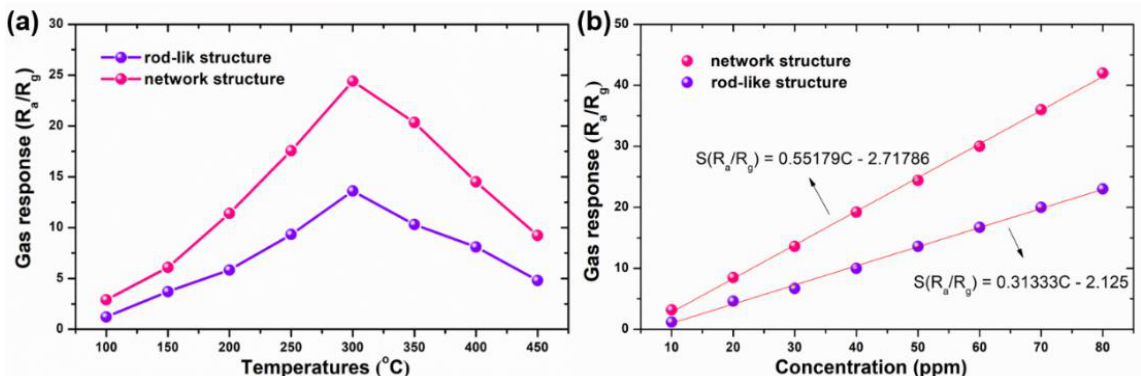
Figure 4. ( a ) The gas response of the network and rod-like WO 3 · H 2 O-based gas sensors at different operating temperatures between 100 °C to 450 °C to 50 ppm H 2 S. ( b ) The gas response of the network and rod-like WO 3 · H 2 O-based gas sensors to different gas concentration between 10 ppm to 80 ppm at 300 °C.